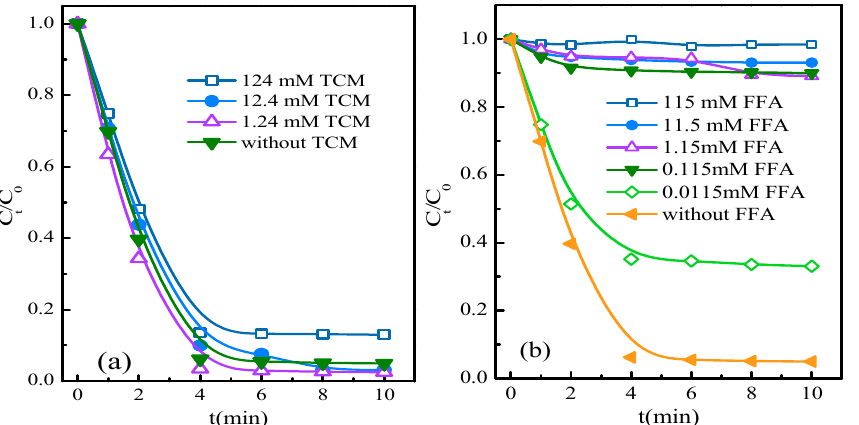
Figure 9. The effects of TCM ( a ) and FFA ( b ) on the decolorization of Orange ([Fe 3+ ] 0 = 100 µM, [Orange II] 0 = 50 µM, [PMS] 0 = 150 µM, [oxalate] 0 = 80 µM, under UVA irradiation, λ irr. = 365 nm, pH 3).